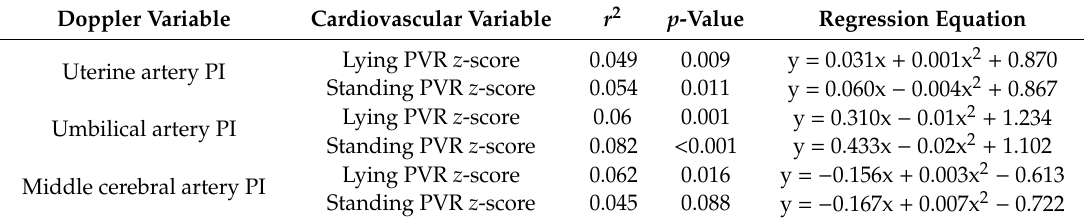
PI, pulsatility index; PVR, peripheral vascular